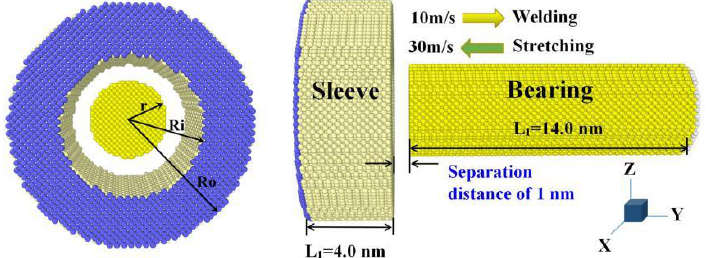
Figure 1. General scheme for the MD (molecular dynamic) welding mode between nanobearing and nanosleeve.